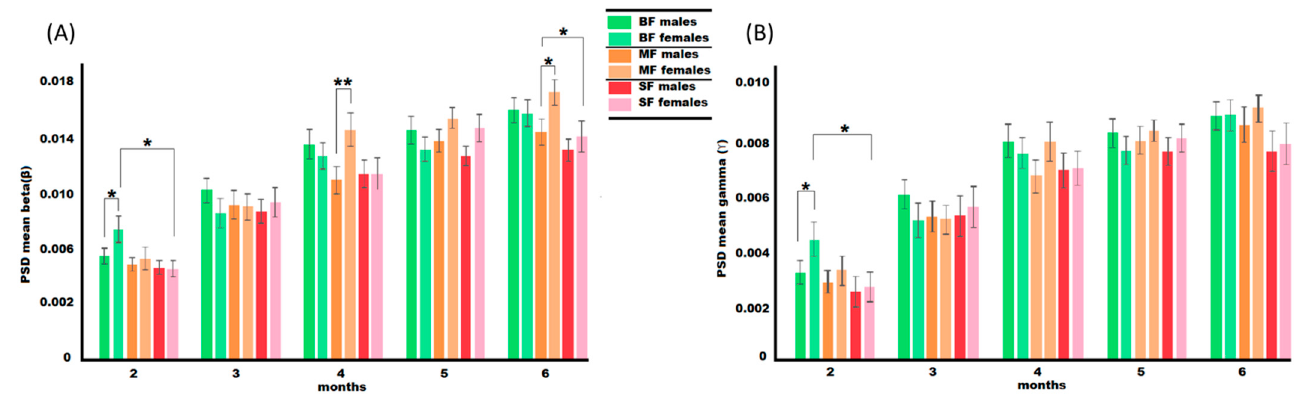
Figure 2. Covariate analysis of the dietary group’s e ff ects on beta ( A ) and gamma ( B ) across 2–6 months of age. Covariates include sex, maternal WASI, gestational age, birth weight, and head circumference at the time of visit. BF: human milk fed; MF: dairy formula fed; SF: soy formula fed. * p < 0.05, ** p < 0.01.